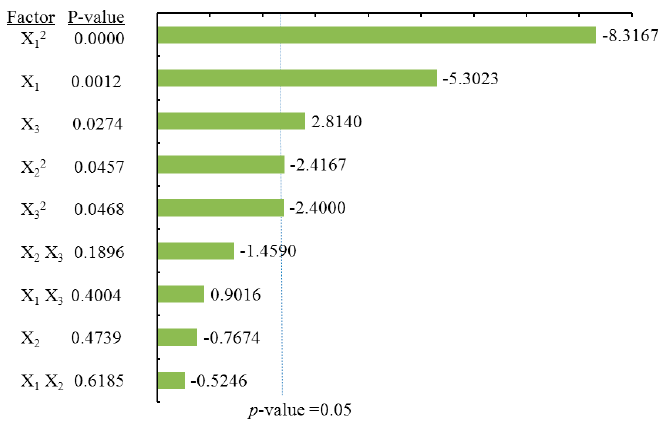
Figure 5. Pareto chart of the effects for the myricitrin yield. Standardized effect estimate (absolute value).